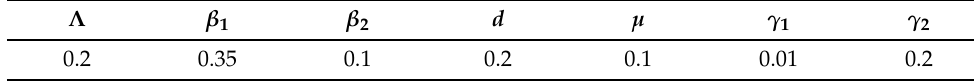
Table 2. Parameter for the global asymptotic stability of E 0 .